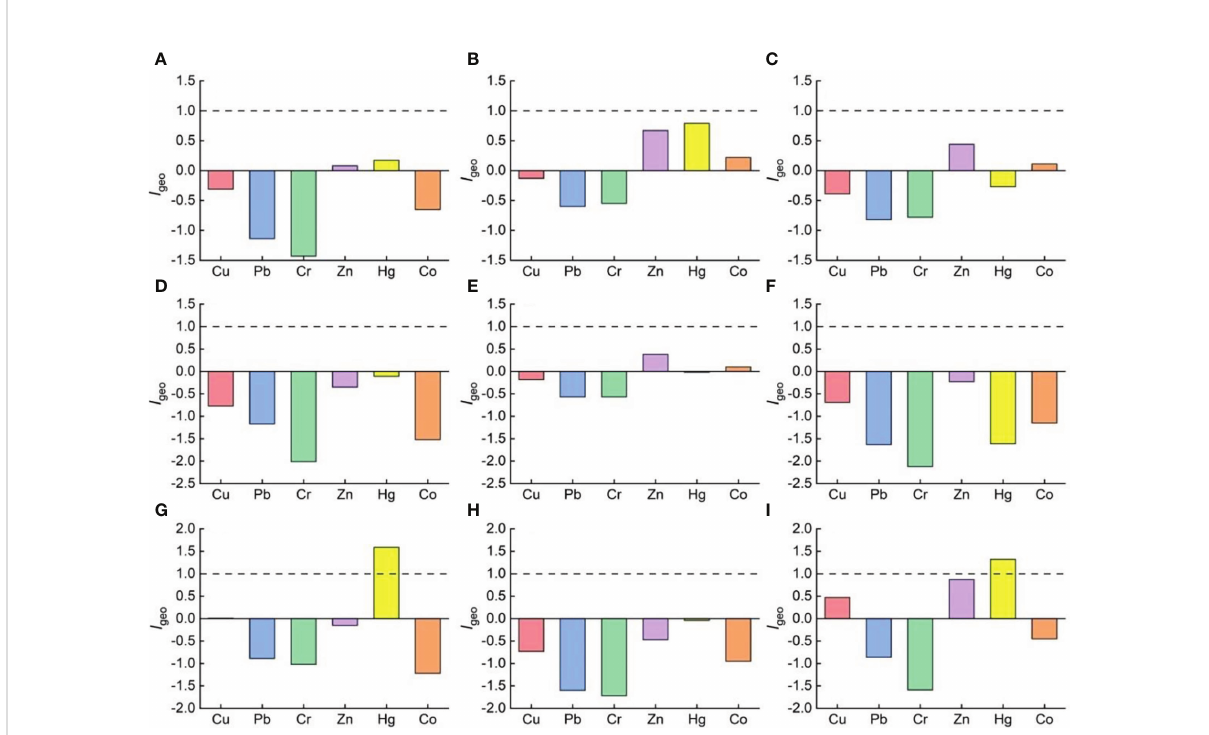
FIGURE 7 Results of the geo-accumulation index of mangrove surface sediments in Zhanjiang Bay ( A-I represents: Total Zhanjiang Bay, DC 、 DTS 、 NS 、 SDJ 、 DM 、 BY 、 TC 、 GHCL).